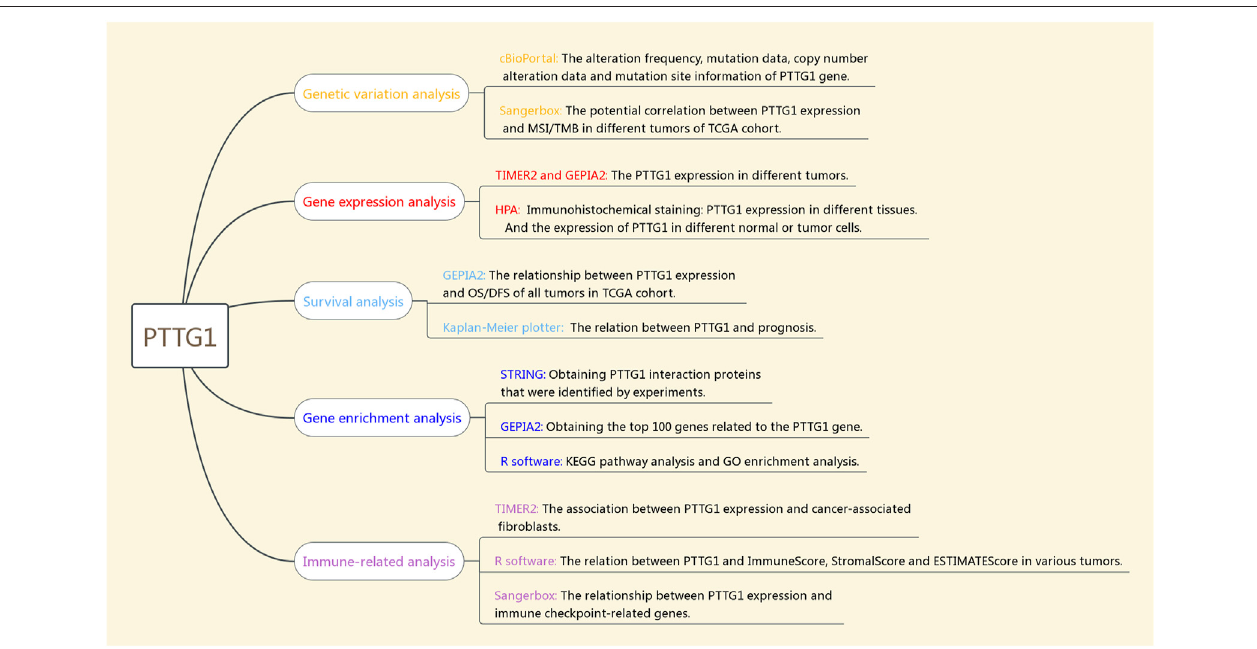
FIGURE 1 | Setup of the integrative and comprehensive Pan-cancer Analysis of